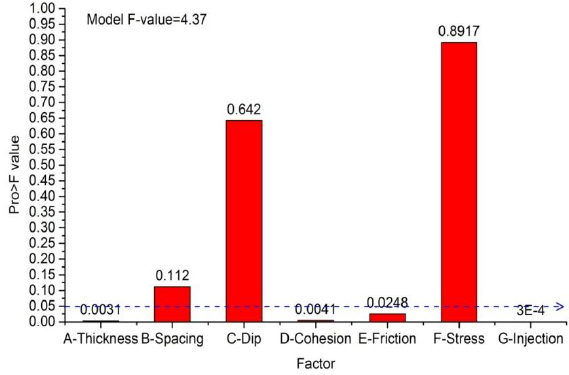
Figure 6. Anova for SRA response surface with linear model.